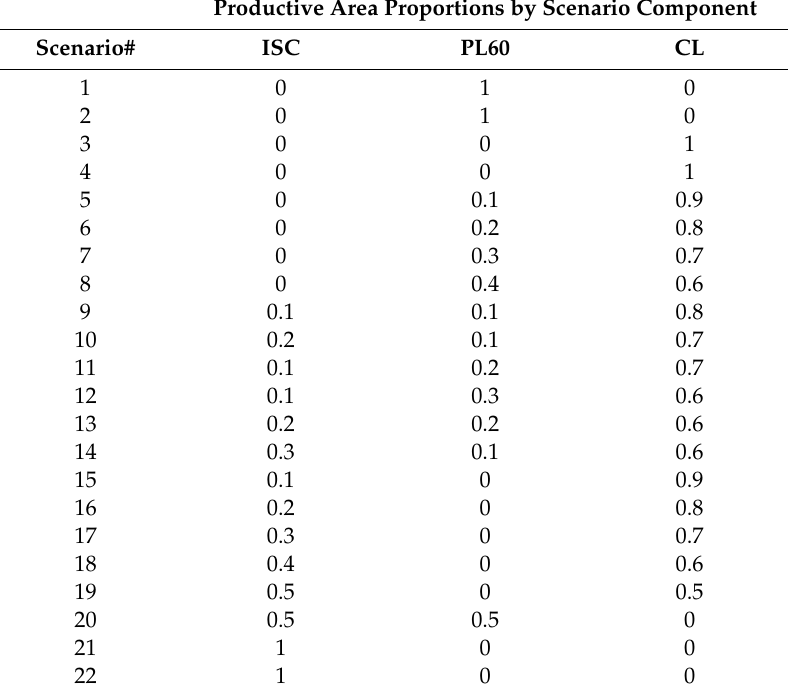
Table 2. Description of management scenarios evaluated.